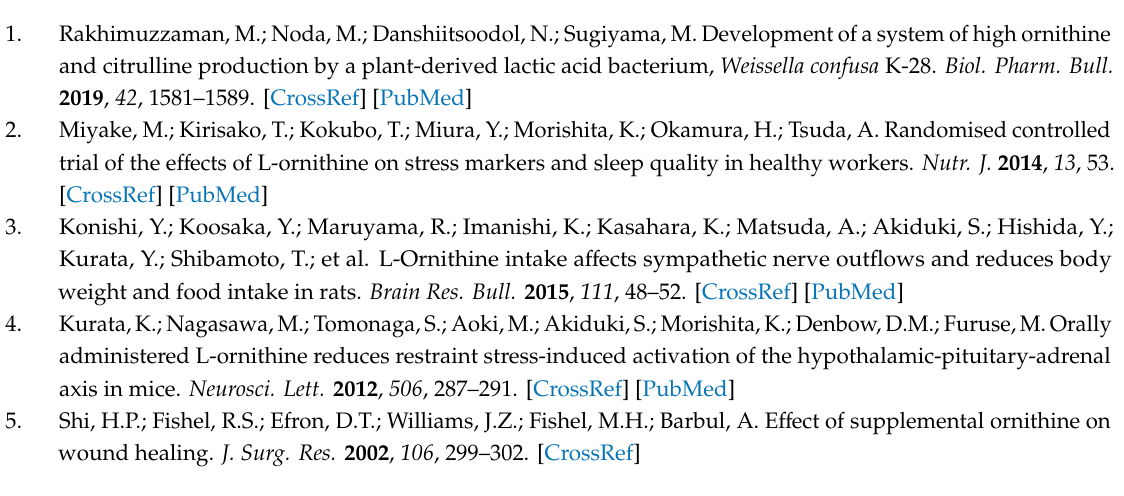
Figure S1: RAPD patterns of LAB. Bands distinctly distinct among LAB strains are marked with red boxes. LAB strains displaying di ff erent RAPD patterns after annealing at di ff erent temperatures are indicated as 1 (cid:79) – 5 (cid:79) , Figure S2: HPLC chromatogram of biogenic amines. Biogenic amine standards: PUT, putrescine; HIS, histamine; AGM, agmatine; and IS, 1,7-diaminoheptane (the internal standard) (A). Culture supernatant of W. koreensis DB1 (B). Culture supernatant of W. koreensis HJ (C). Figure S3: TLC analysis of LAB cultures. W. koreensis DB1 and W. koreensis HJ were incubated in MRS broth supplemented with 0.5–3.0% arginine for 24 h (A) or 48 h (B). Cultures were then analyzed by TLC as described in Materials and Methods. 1: arginine standard, 2: ornithine standard, 3–6: initial pHs of the cultures were adjusted to pH 5.0 for DB1 and to pH 8.0 for HJ, and 7–10: pHs of cultures were not adjusted (controls). Table S1: Similarities of the 16S rRNA gene sequences of LAB isolates with those in the GenBank database. Table S2: Viable cell determination according to addition of corn steep liquor and glucose in rice bran